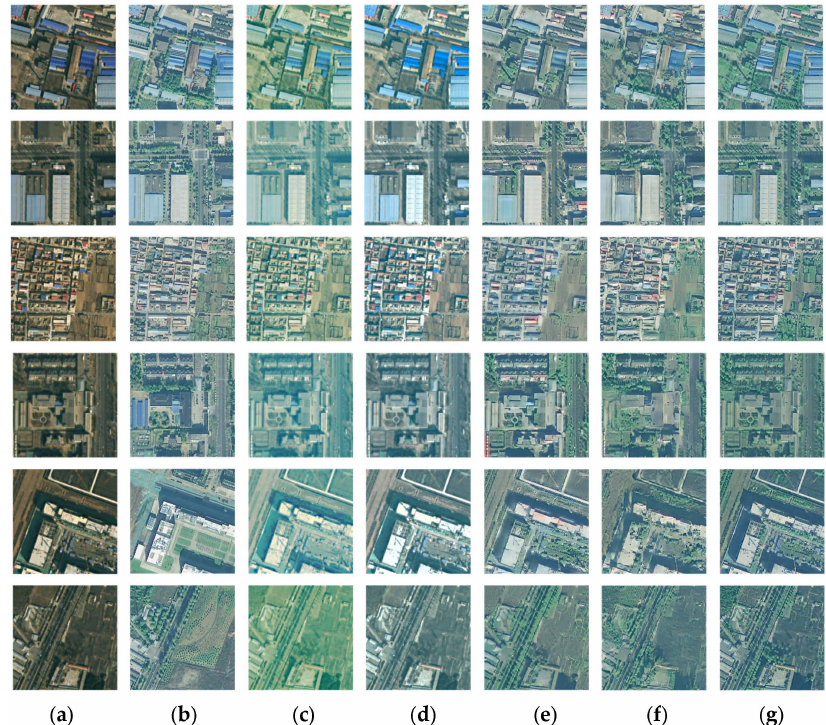
Figure 7. Image color translation results obtained on the Beijing Huairou district land survey dataset, ( a ) 2018 image, ( b ) 2019 image, ( c ) HM, ( d ) Reinhard method, ( e ) DRIT, ( f ) UNIT, and ( g )